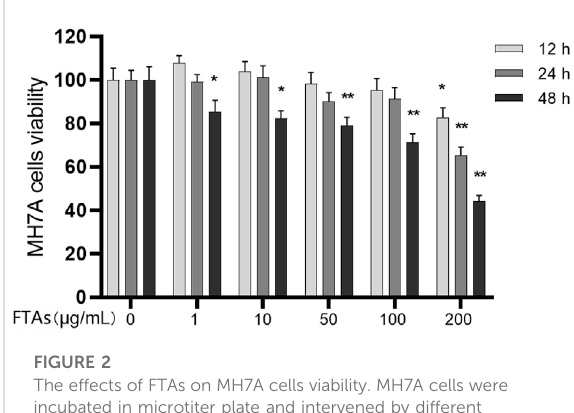
levels of IL-1 β , IL-6, MMP-1, MMP-3, PGE2, TGF- β , and